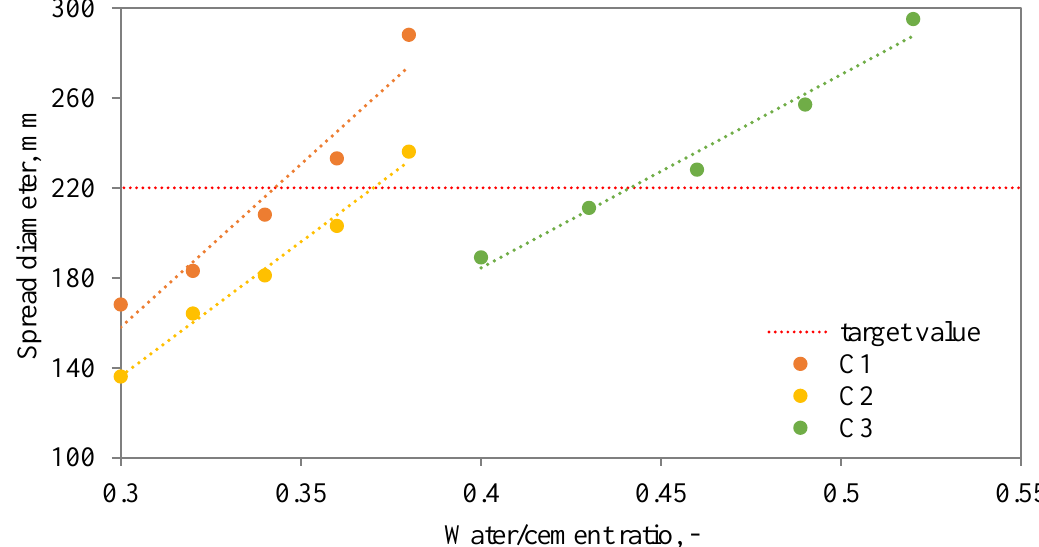
Figure 5. Dependency between spread diameter and additional water dosage for C mixtures.